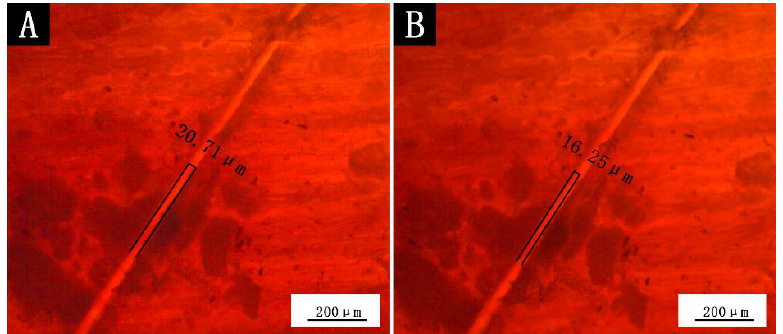
Figure 6. Testing of the self-healing properties of the coating ( A ) for 1 day and ( B ) for 3 days.